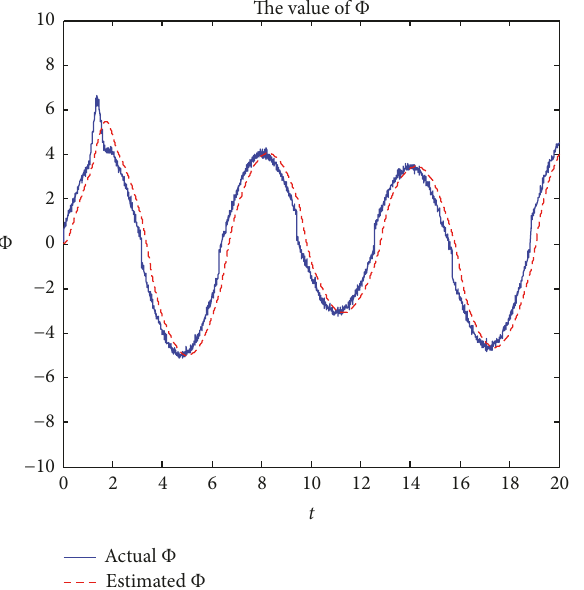
Figure2:Combination Φ(𝑥 1 , 𝑥 2 ,𝑡) estimateandtruevaluefor 𝑓 1 (𝑡) .